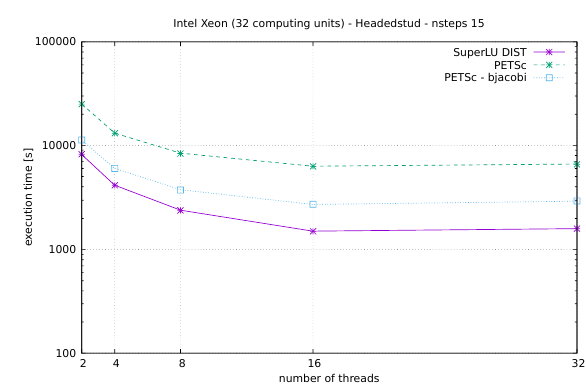
Figure 8. Execution times using the Initial Stiffness Matrix method.